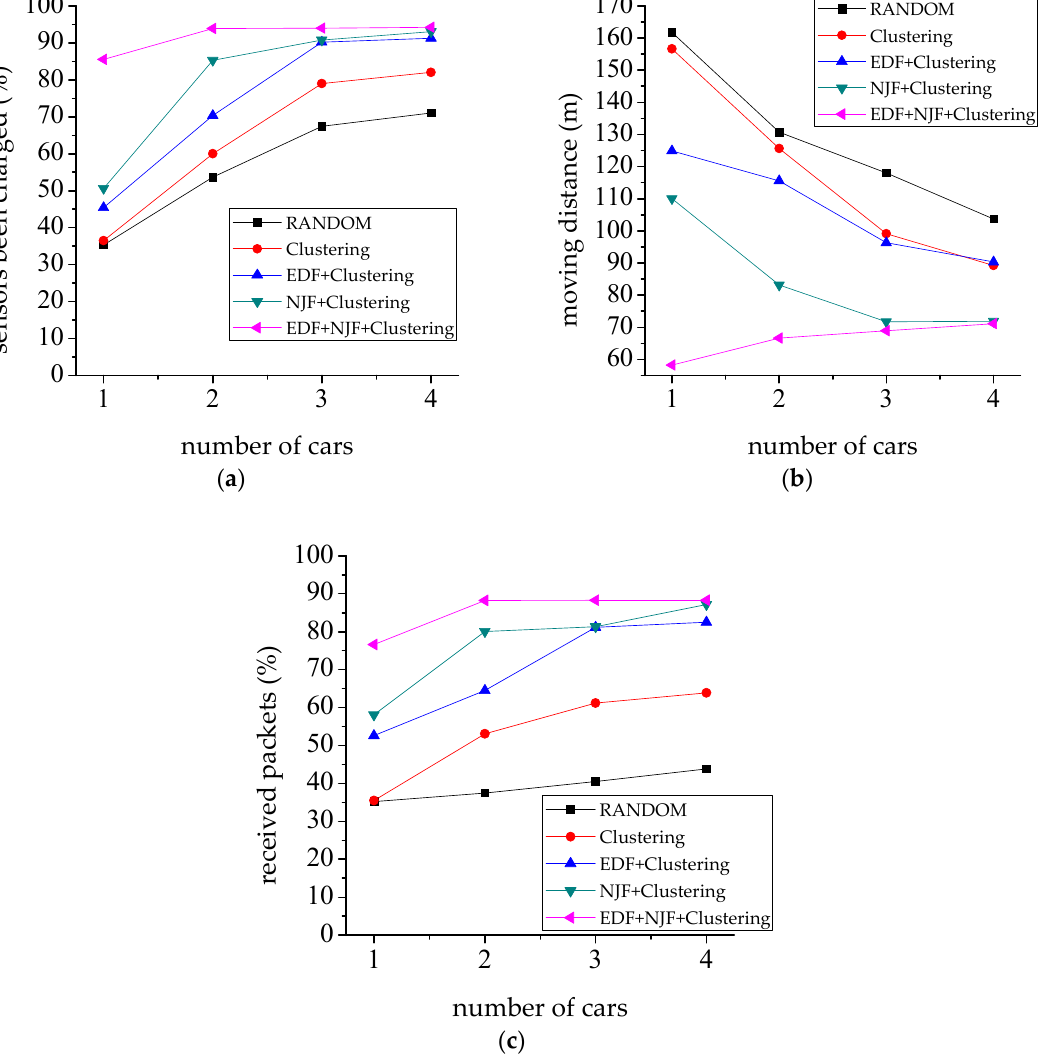
Figure 8. Performance comparisons among variations of our proposed algorithm in terms of: ( a ) percentage of sensors being charged successfully, ( b ) average moving distance of charging vehicles, and ( c ) percentage of successful data packets delivery. Note that simulation time and network traffic are set at 10,000 s and [0, 100/ n ], while the other parameters are the same as shown in Table